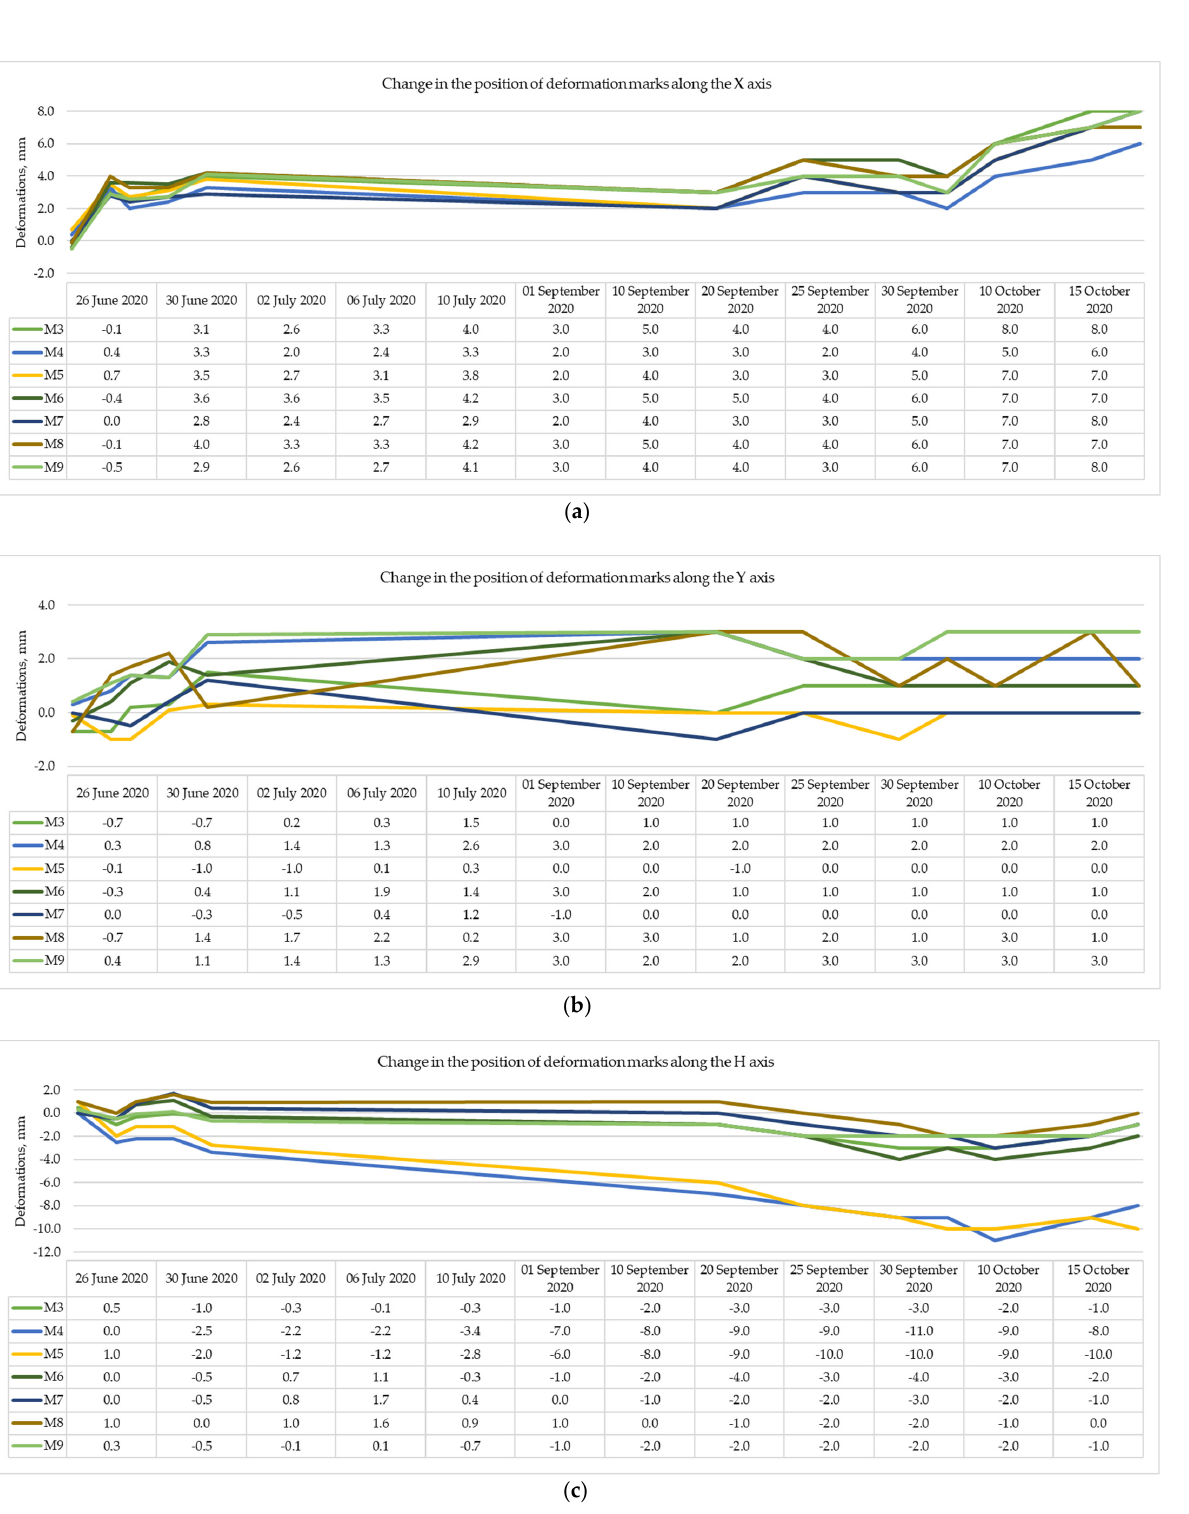
ling the stability of the building, confirmed that the chosen method of strengthening the structures provided the necessary time and safe conditions for a detailed survey of the damaged building by specialists and increased the safety of residents during evacuation. The informational–mathematical model was refined after a detailed survey of the damaged building. An analysis of the defects and damage that changed the main design and boundary conditions for the calculation was conducted. This included characteristics of structures, determination of actual operating loads and effects on building structures, displacements in bases and foundations, and building services systems. Detailed geodetic measurement of the necessary geometric parameters of the building was carried out, and verification calculations of the main load-bearing building structures, engineering sys- tems, foundation, and object as a whole were performed. The analysis of the detailed data on the defects and damage enabled a more precise estimation of the technical conditions of building structures and engineering systems. As a result, the section of the building was deemed unfit for further operation and was dismantled [45]. The result of the analysis of the case study. The above case study shows that infor- mation–mathematical modeling combined with displacement and deformation monitor- ing can be used for both the initial assessment and continuous monitoring of the building structural stability for residential large-panel buildings. In the current situation in Ukraine, most decisions on emergency stabilization and determination of the further operational suitability of the building are made under the pressure of time and with insufficient in- formation. However, having typical large-panel buildings models would help to increase the precision of structural behavior and reduce surveying and modeling time. Due to the lack of time to compile an information–mathematical and calculation model, and considering the level of devastation, it is expedient to develop a database of typical BIM-based building models and accumulate information on typical damages, as